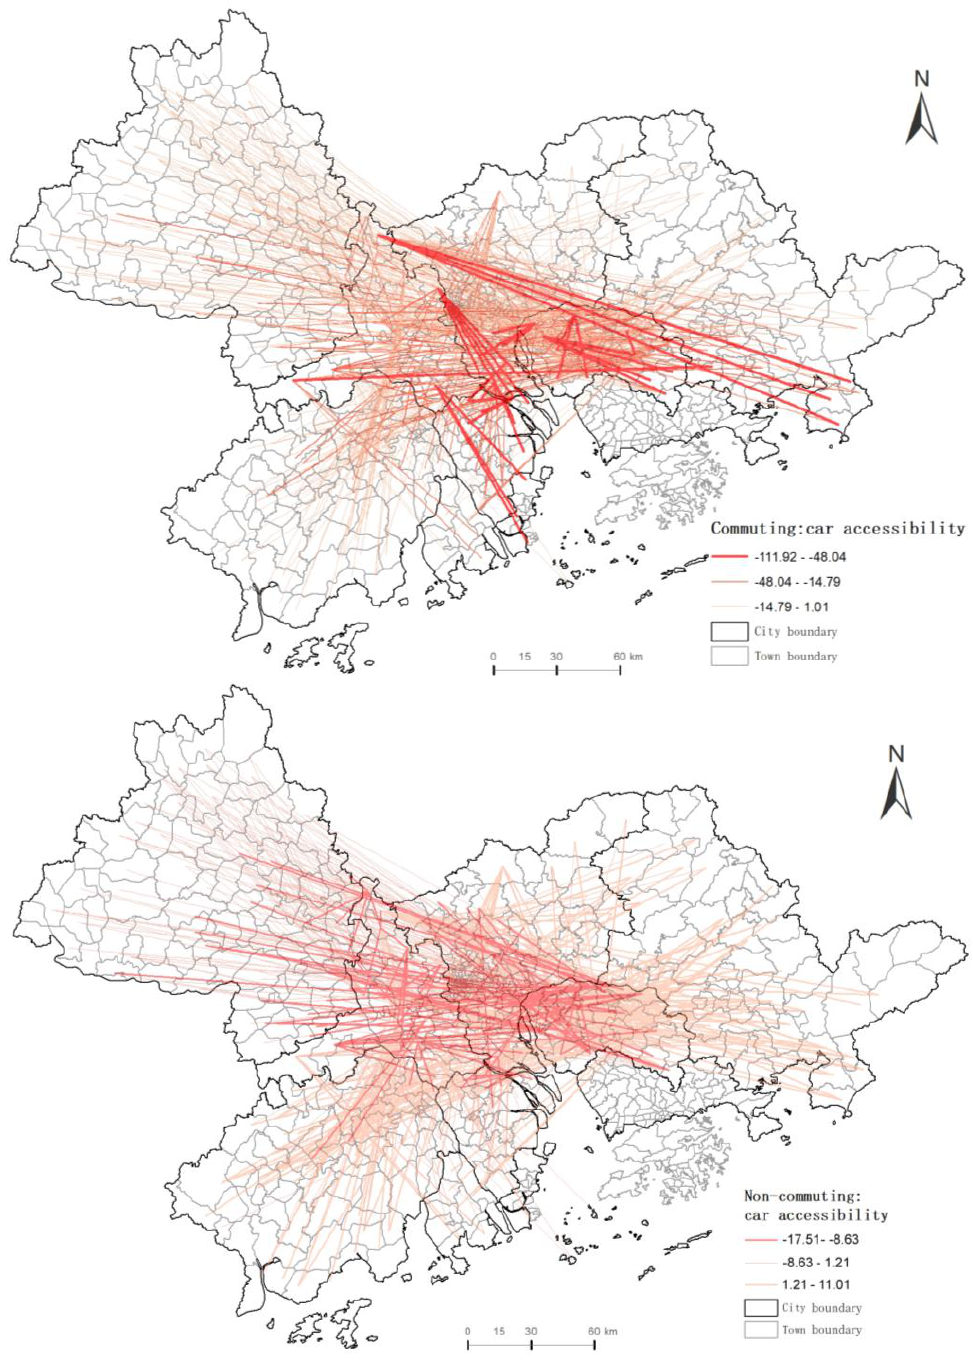
Figure 5. The local effect of car accessibility on rural mobility.